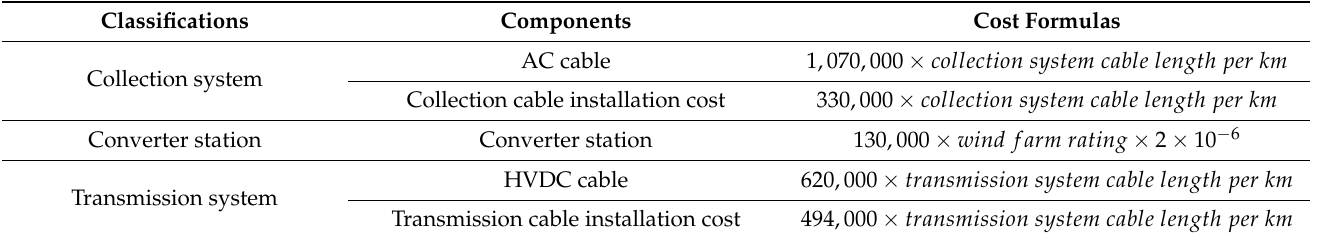
Table 8. Cost formulas for the FOWF components [37,38].